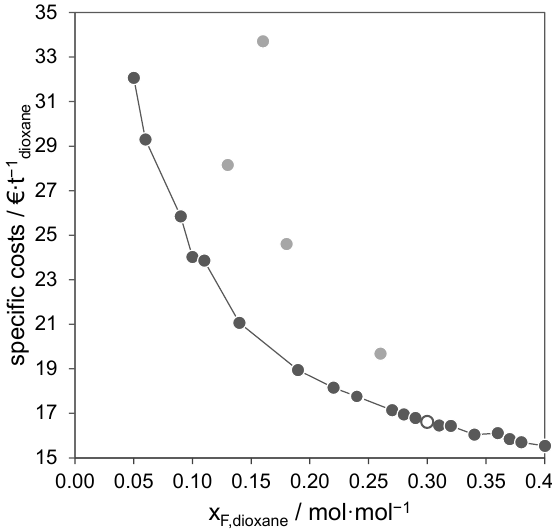
Figure 13. Specific costs of 1,4-dioxane for variable feed compositions. The white circle indicates the feed composition from Section